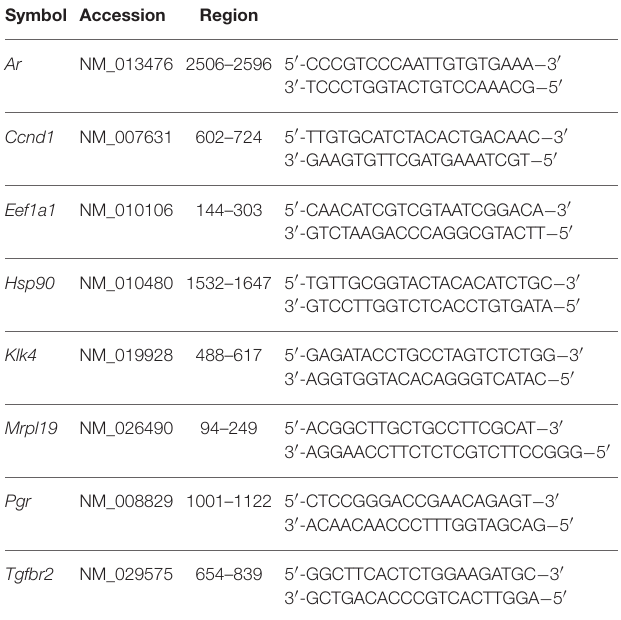
TABLE 1 | Mouse specific primers for qPCR. Symbol